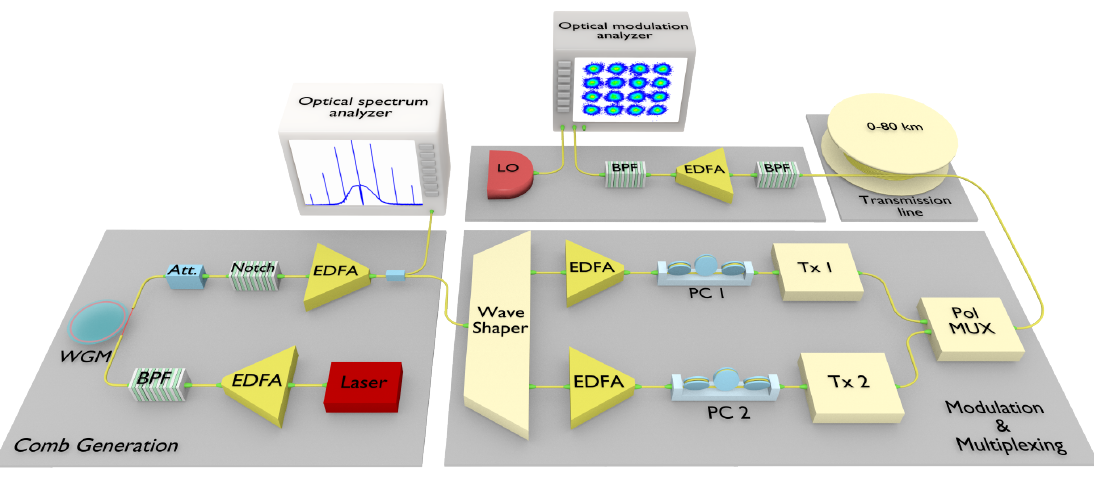
Figure 8: (Color online) Schematic representation of the experimental setup for ultra-high capacity optical coherent telecommunications. A Kerr comb is used as a multi-wavelength coherent source fo WDM optical telecommunications. EDFA, erbium-doped fiber amplifier; BPF, bandpass filter; PC, polarization controllers; PolMUX, polarization multiplexing; LO, local oscillator. The signal of a CW laser is first am- plified and filtered to reject the EDFA noise. This signal is used to pump an ultra-high- Q WGMR, and a coherent Kerr comb (primary comb corresponding to a roll patern) is obtained at the output port. This comb is amplified, and a notch filter attenuates the center mode to a level comparable to the first-order side modes of the comb. A programmable filter is used for interleaving, flattening, and filtering the comb lines. Two EDFAs boost the carriers, which are fed via polarization controllers to two transmiters. The data streams are then multiplexed, mergedand, launched in the transmission fiber. At the receiver end, the data streams are band-pass filtered and amplified before being co- herently detected with an external cavity laser serving as a local oscillator. The received data are visualized using constellation diagrams that display the real and the imaginary part of the optical amplitude in the complex plane. This experiment enabled to transmit data at up to 144 Gbit/s per